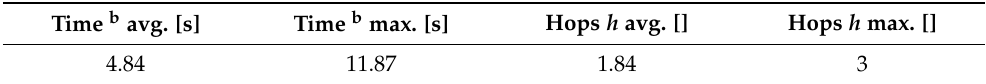
Table 5. Latency and hops per successful task